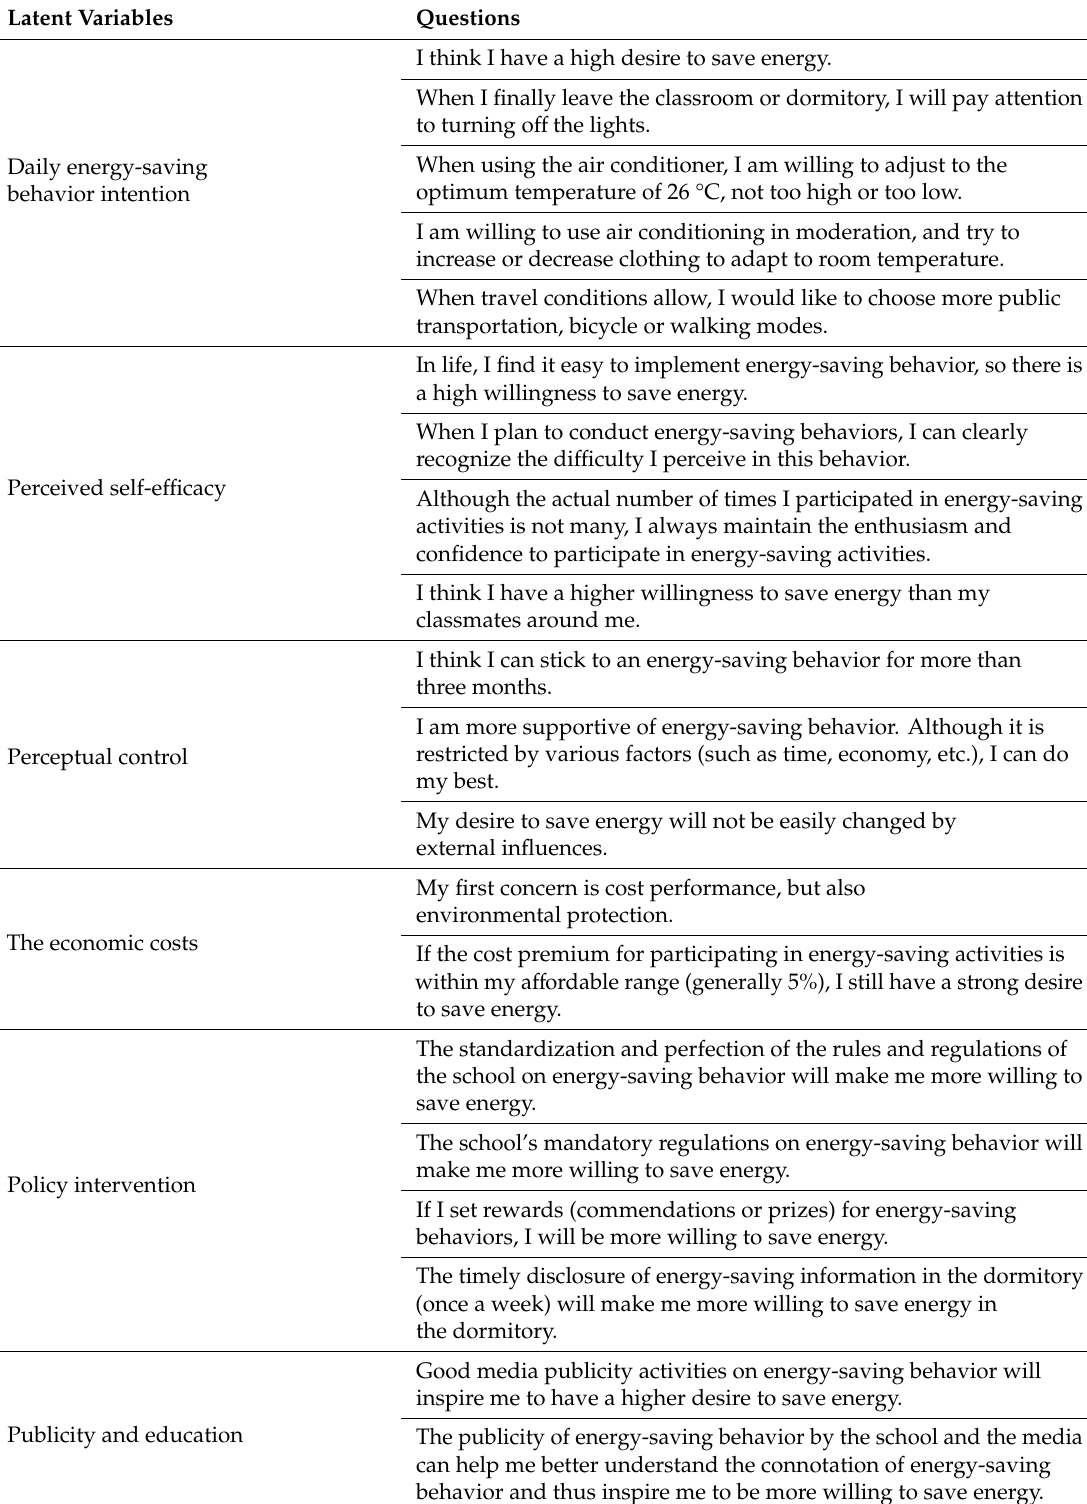
Table A1. Research